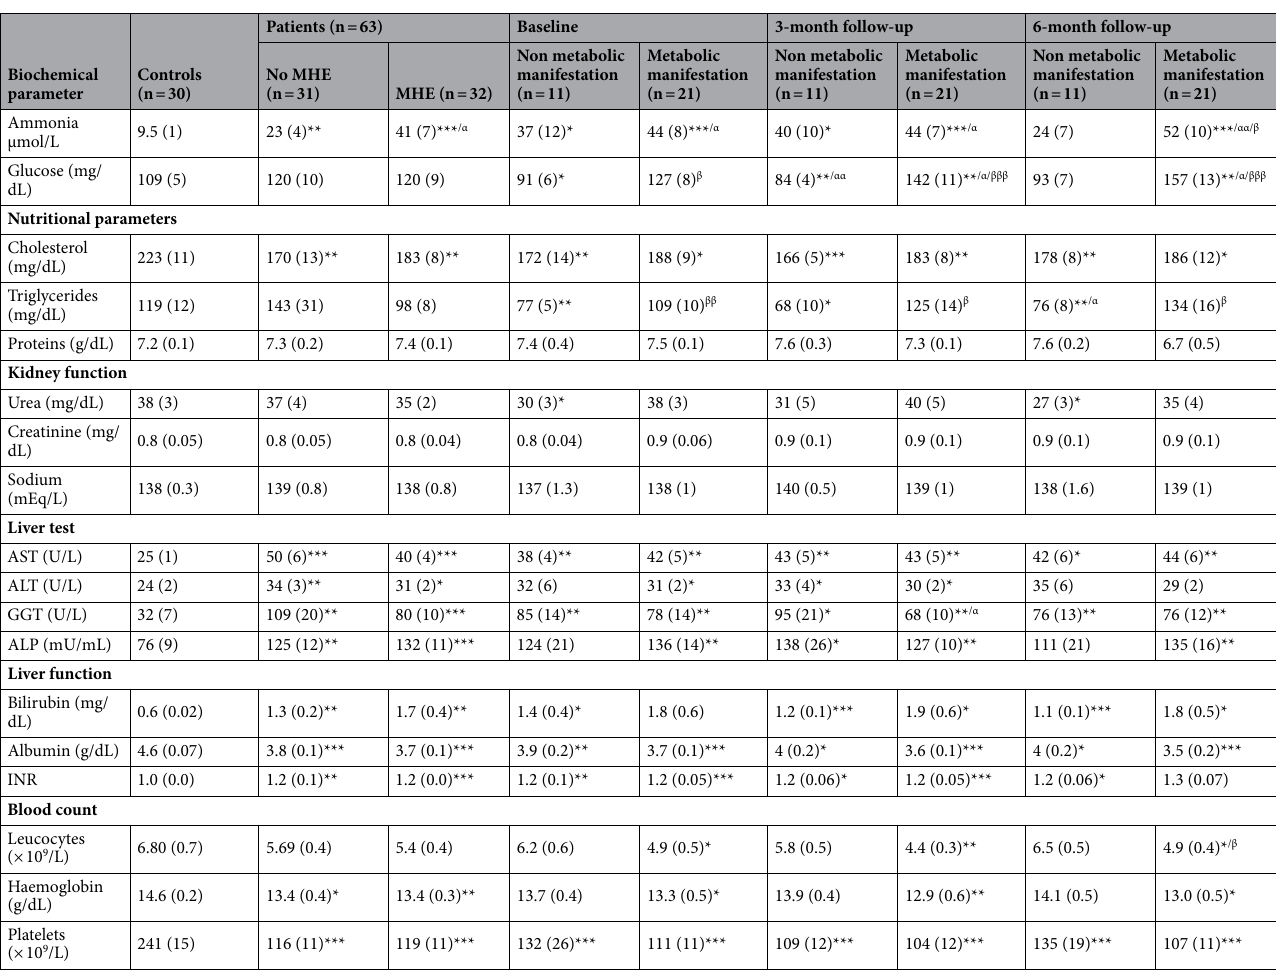
Table 3. Biochemical parameters at baseline and follow-up according to metabolic syndrome manifestations. All values are expressed as mean (SEM). *significant differences from controls (* p < 0.05; ** p < 0.01; *** p < 0.001). α significant differences from no MHE ( α p < 0.05; αα p < 0.01; ααα p < 0.001). β significant differences from patients without metabolic syndrome manifestations ( β p < 0.05; ββ p < 0.01; βββ p < 0.001). ∂ significant differences from baseline ( ∂ p < 0.05; ∂∂ p < 0.01; ∂∂∂ p < 0.001). Abbreviations: AST: aspartate aminotransferase; ALT: alanine aminotransferase; GGT: gamma glutamyl transferase; ALP: Alkaline phosphatase; INR: international normalized